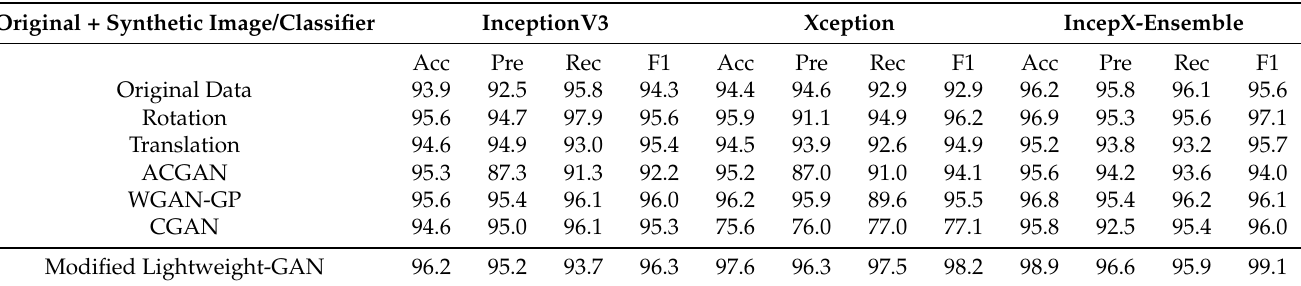
Table 7. Evaluation of our proposed model on the ImageNet